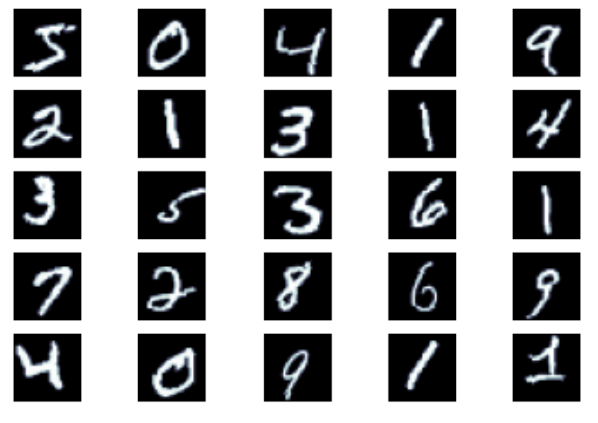
Figure 5. Examples of MNIST